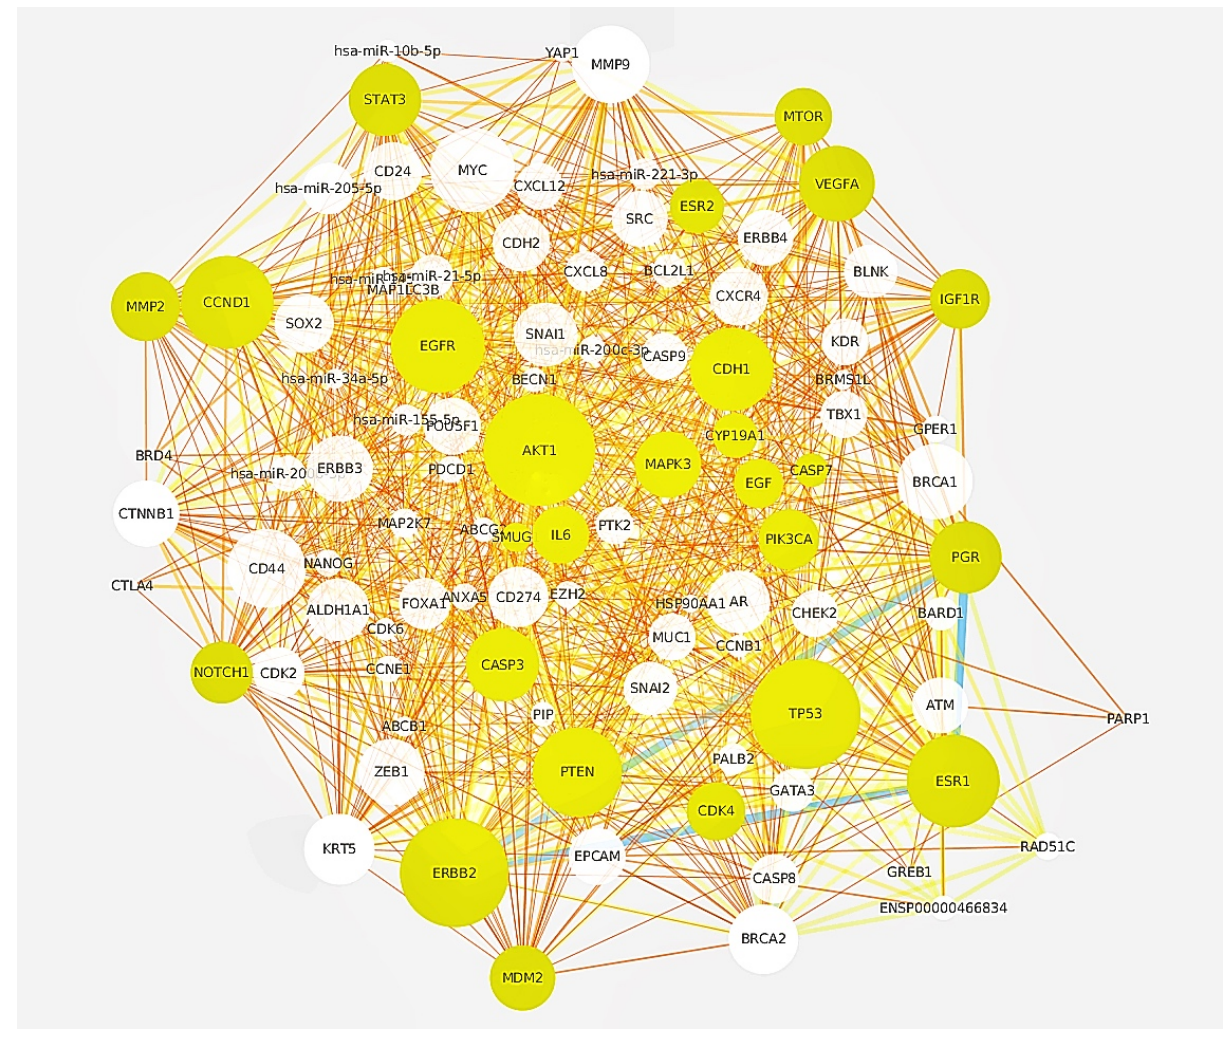
Figure 4. Visualization of the extracted gene pairs from